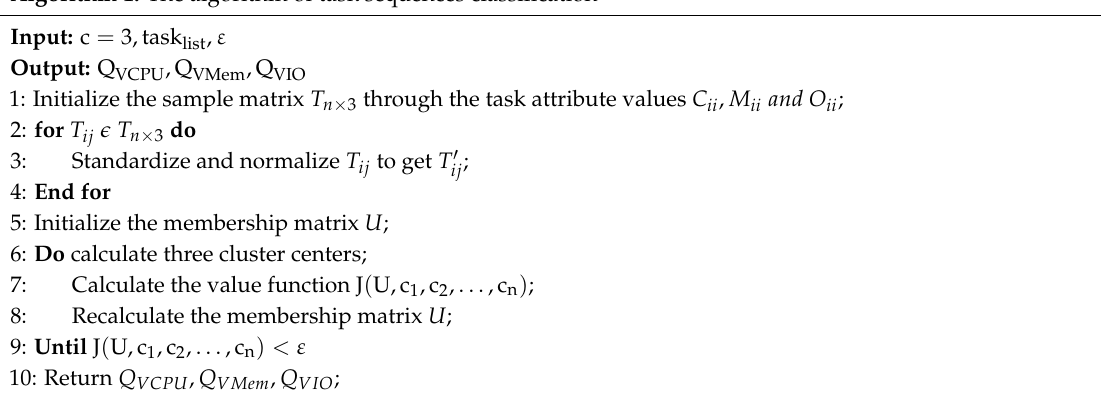
Algorithm 1: The algorithm of task sequences